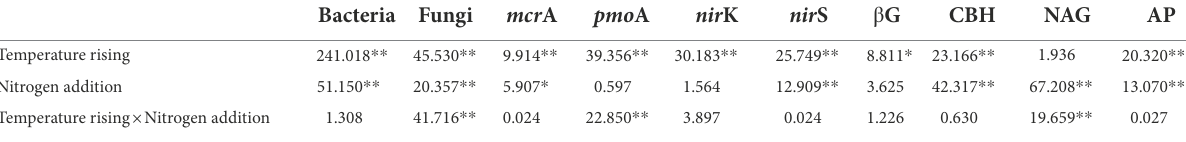
TABLE 2 Two-way ANOVA of the effects of nitrogen addition and temperature rising on soil microbial abundances and enzyme activities. Bacteria Fungi